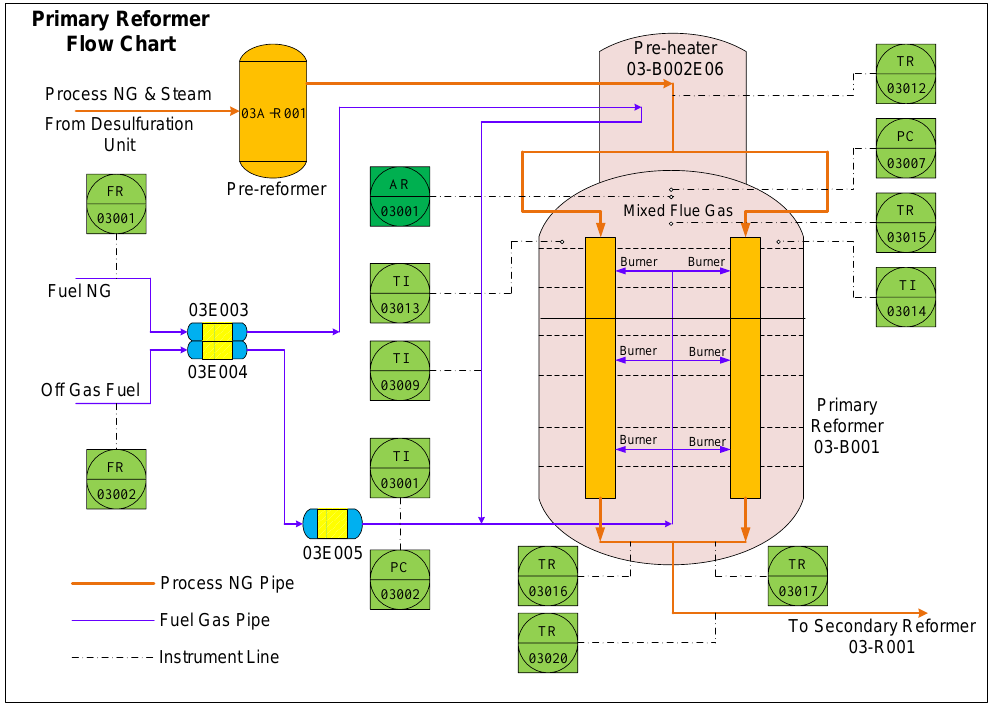
Figure 8. Flowchart of the primary reformer.